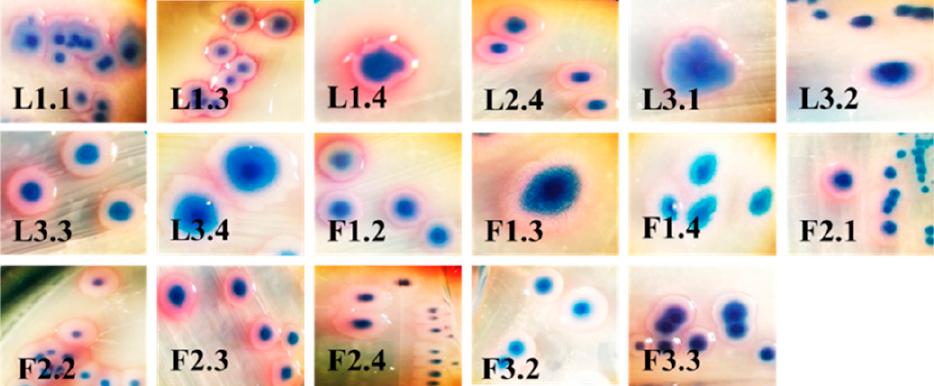
Figure 1. Morphological characteristics of bacterial strains, which were suspected for Escherichia coli ( E. coli ). Legend: L, lagoon; F, faeces; the first number, the number of probe; the second number, the number of isolate.